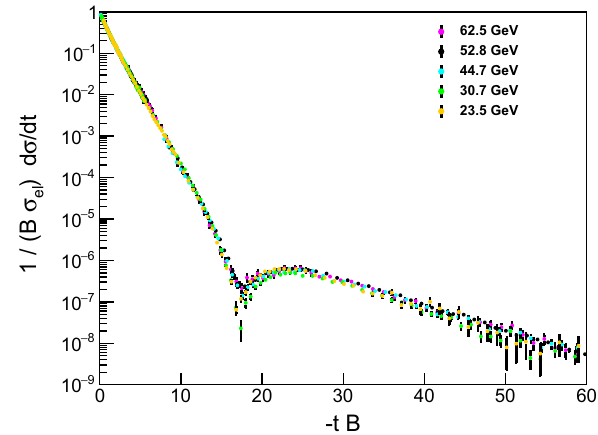
√ s = 23 . 5 − 62 . 5 GeV. d σ as a B σ el dt